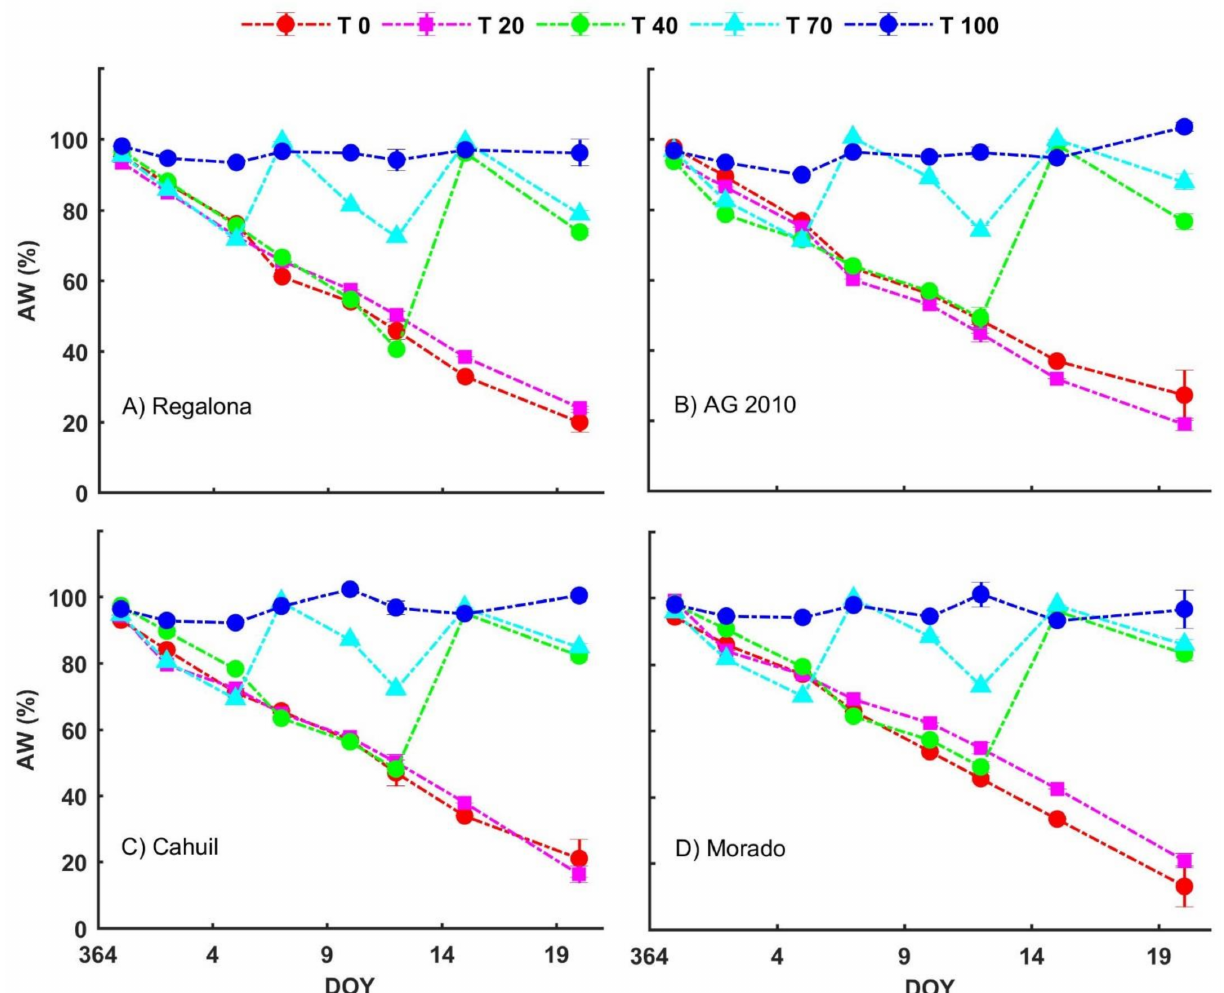
Figure 2. Evolution of available water (AW) in five irrigation treatments (T), T0, T20, T40, T70, and T100, and four quinoa genotypes: ( A ) Regalona, ( B ) AG 2010, ( C ) Cahuil, and ( D ) Morado, between the beginning of grain filling throughout the physiological maturity stages, in the 2014/2015 season. AW and 0, 20, 40, 70, and 100 represent the levels of available water to the plant in a 0.6 m deep root zone just before irrigation. DOY is the day of year. Bars indicate ± one standard